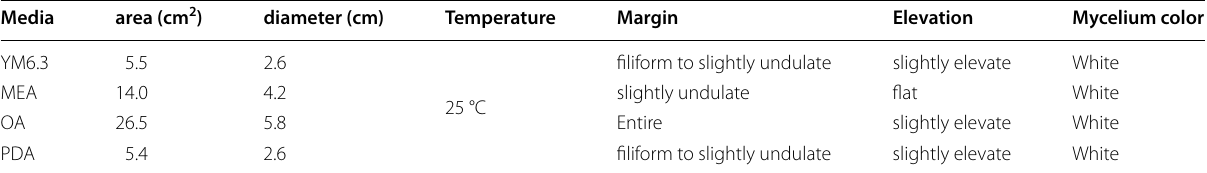
Table 2 Rates of growth and culture characteristics of Induratia apiospora ATCC60639 in four different media at four weeks of